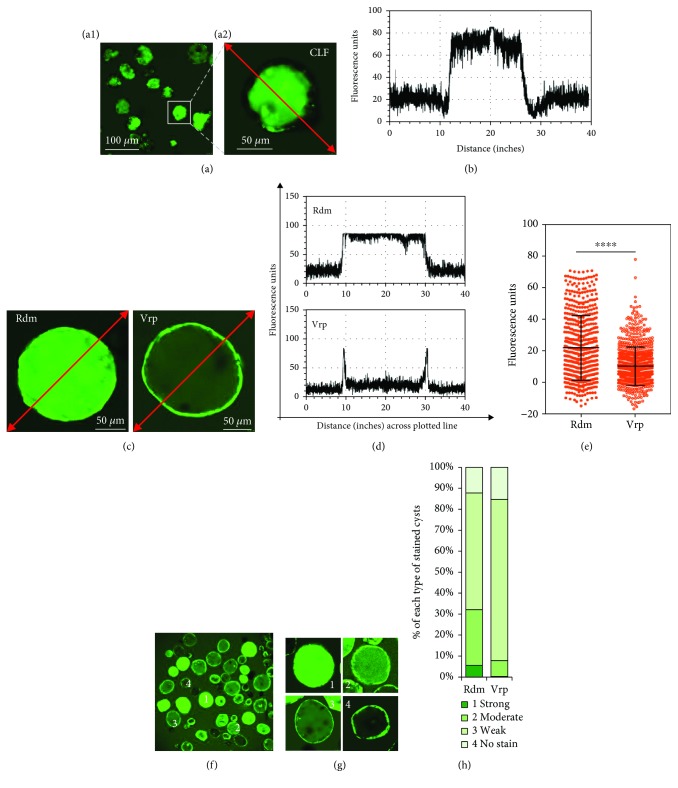
Spontaneously formed 3D cysts are functional (see also ). (a) Representative fluorescence images at low magnification (a1) and high magnification (a2) demonstrate active transport of the fluorescent bile acid cholyl-lysyl-fluorescein (CLF) into the lumens of cysts. (b) Fluorescence intensity (FI) measurements along the red line in images from (a). (c) Representative fluorescence images demonstrating secretion of fluorescent rhodamine 123 (Rdm) into cyst lumens; secretions were inhibited by the Mdr1 inhibitor verapamil (Vrp), thus confirming that Mdr1 is functional. (d) FI measurements along the red line in the images from (c). (e) Mean intraluminal FI was normalized to background fluorescence in the absence (Rdm) or presence (Vrp) of verapamil; n(Rdm) = 573, n(Vrp) = 765 measurements. Data are shown as means ± s.d.; ∗∗∗∗P < 0.0001 (two-tailed Mann-Whitney U test). (f) A representative low-magnification fluorescence image with varying FI in the lumens of cysts 1, 2, 3, and 4. (g) High-magnification image of that shown in (f); 1: strongly stained cyst (FI > 60); 2: moderately stained cyst (30 < FI ≤ 60); 3: weakly stained cyst (0 < FI ≤ 30); 4: nonstained cyst (FI ≤ 0). (h) The bar graph of percentages of the four types of stained cysts demonstrates that Mdr1 function in cysts is inhibited by verapamil.